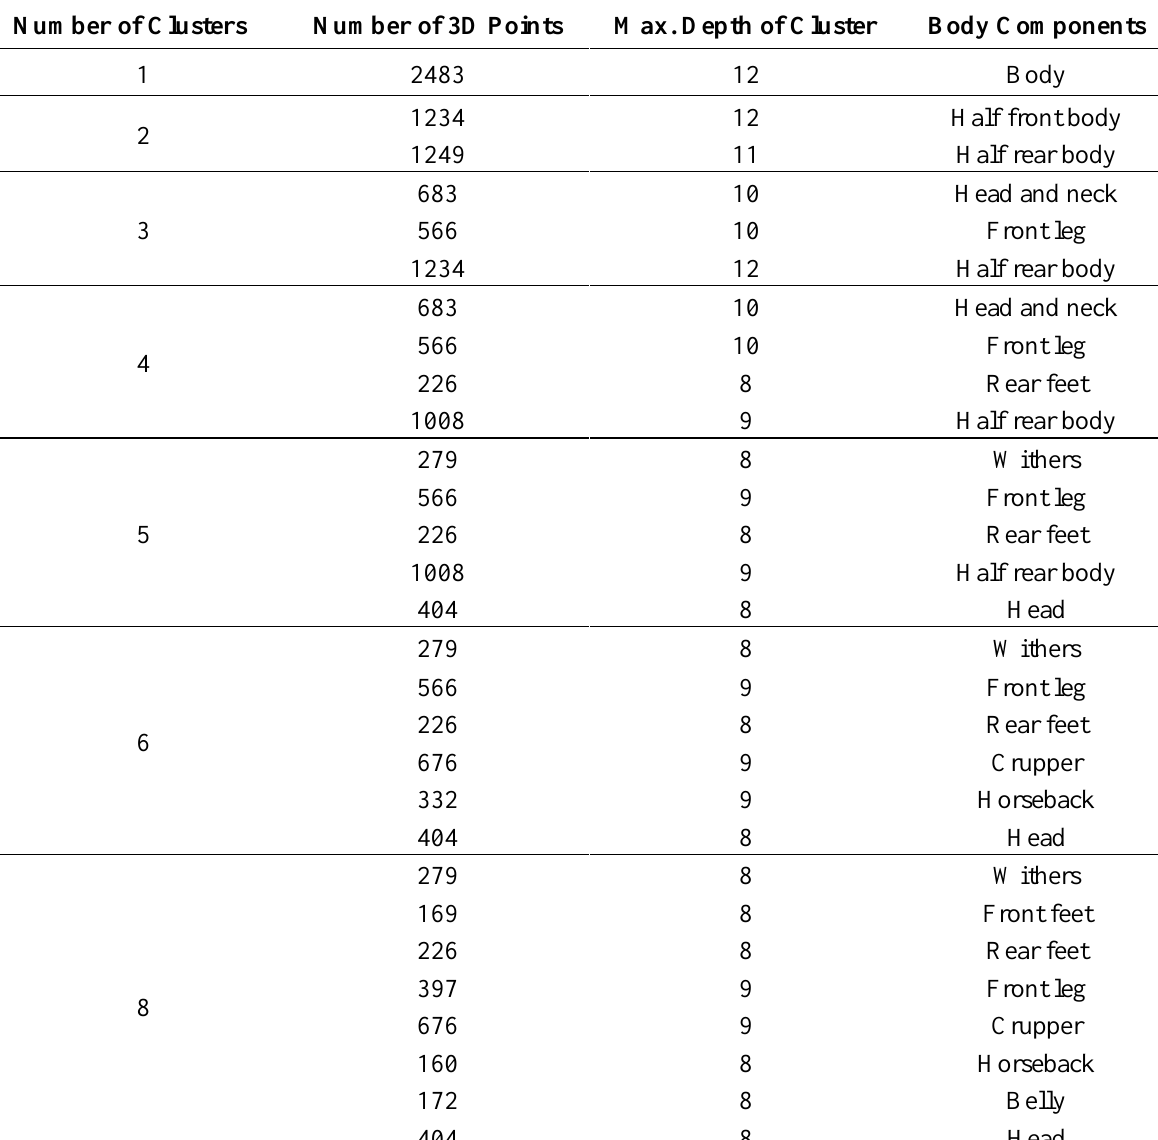
Table 3. Horse clustering and